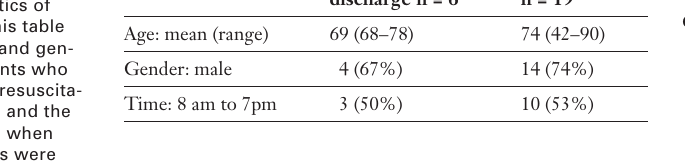
Initial rhythms and follow up. This table shows the initial rhythms and follow up of patients who underwent resuscita- tion